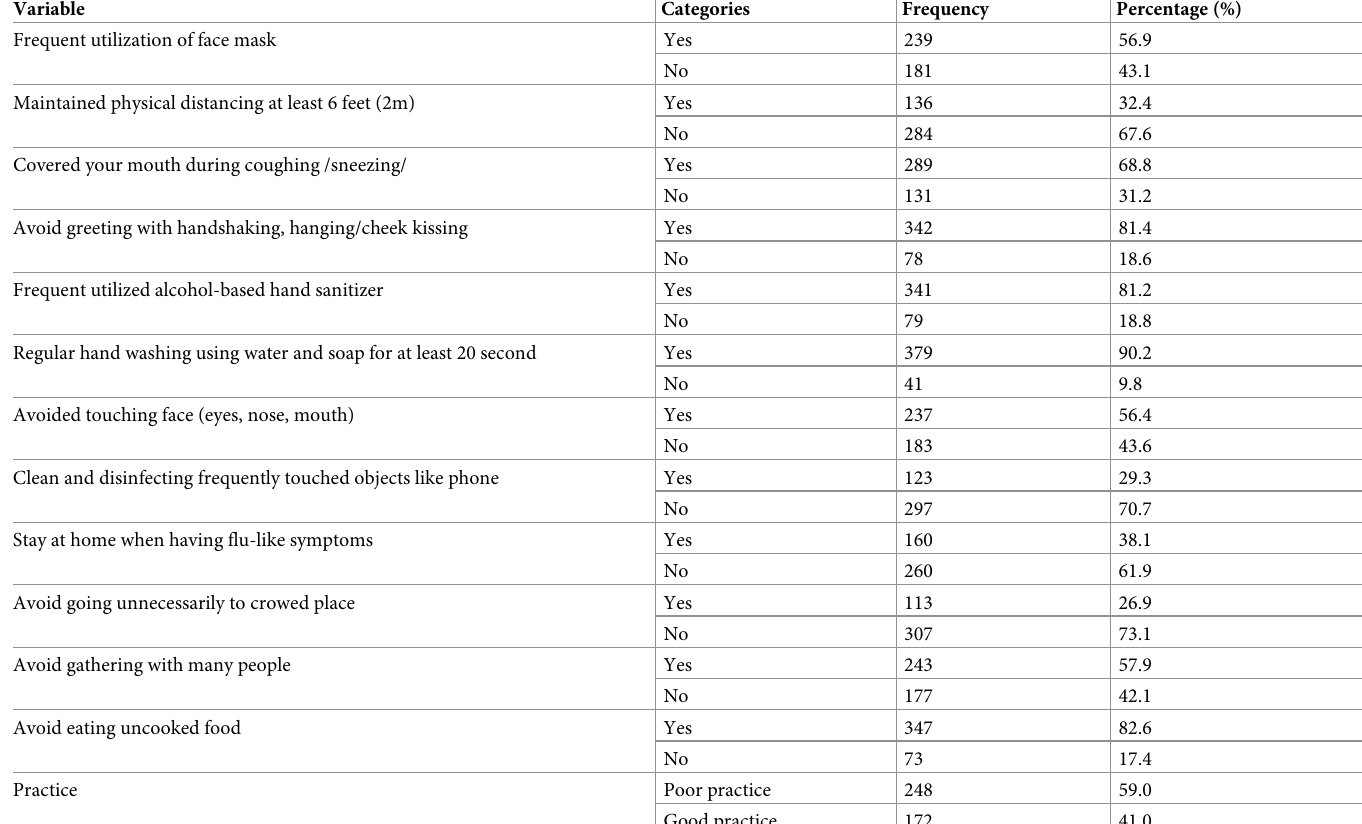
Table 4. Practice of COVID-19 mitigation measures among medical and health science students attending Wolkite University, Ethiopia, 2021 (n =